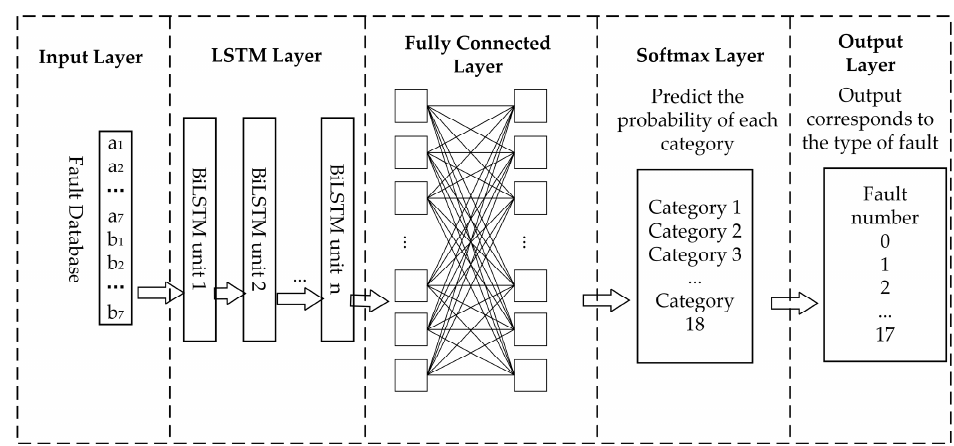
Figure 12. LSTM model diagnostic framework diagram.